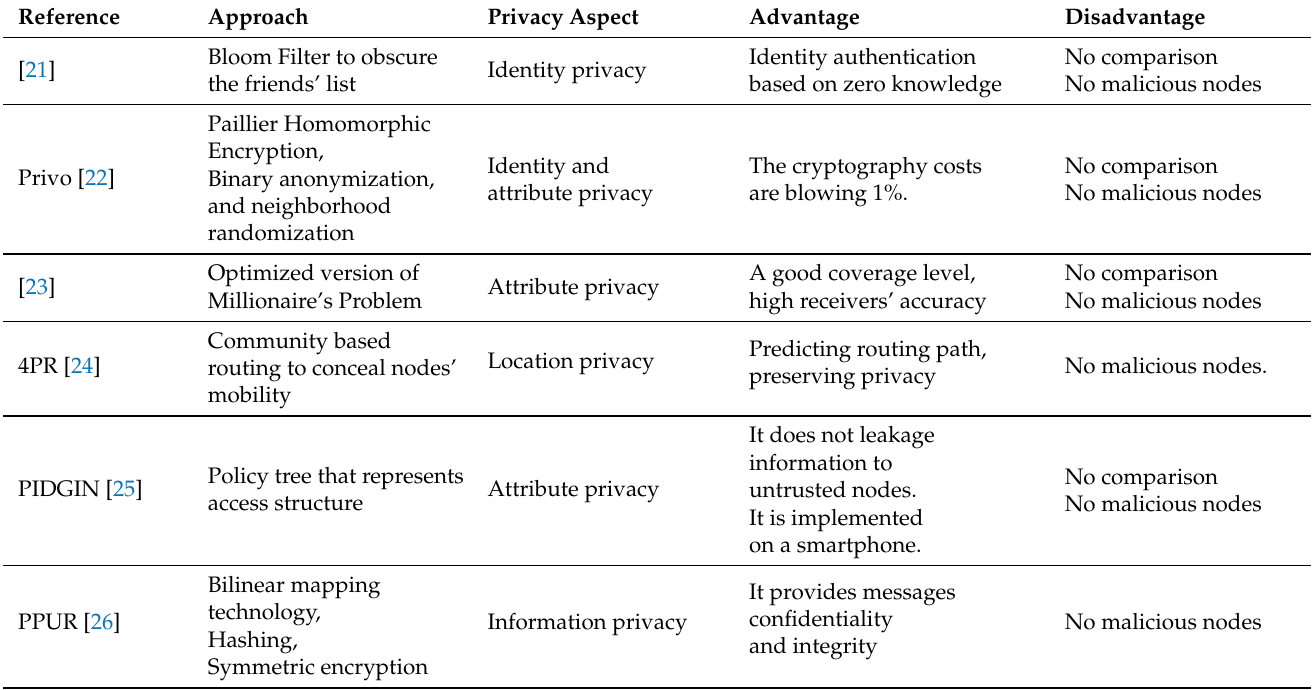
Table 1. Compression of different privacy-preserving algorithms in OppNet. No comparison in the table indicates that the performance of the references has not been compared with the other routing algorithms. No malicious nodes indicates that the effect of malicious nodes has not been considered in the